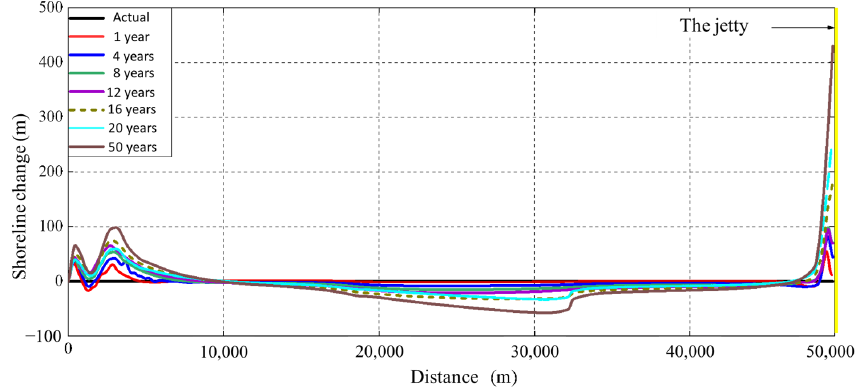
Figure 27. Shoreline change from Cua Dai estuary to Cua Lo estuary.